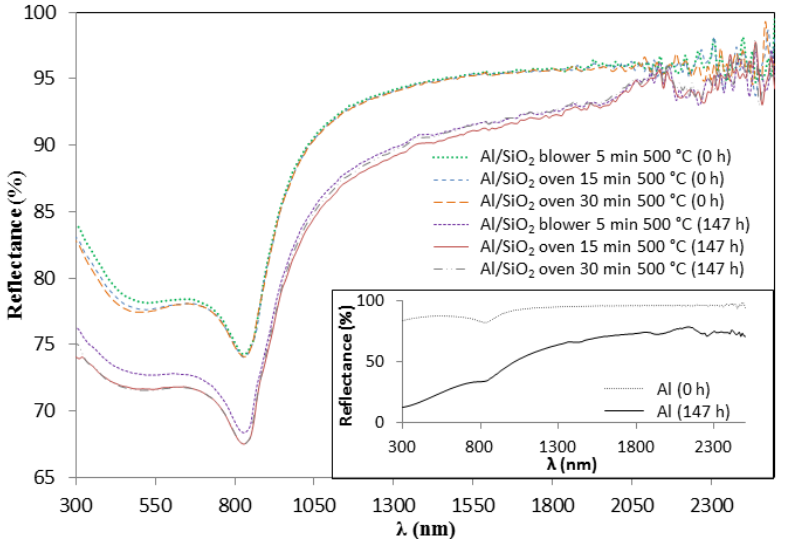
Figure 11. Variation of the hemispherical reflectance spectra of the Al/SiO 2 samples before and after 147 h of condensation test. Hemispherical reflectance spectra of the bare Al substrate after 147 h of condensation test (inset).